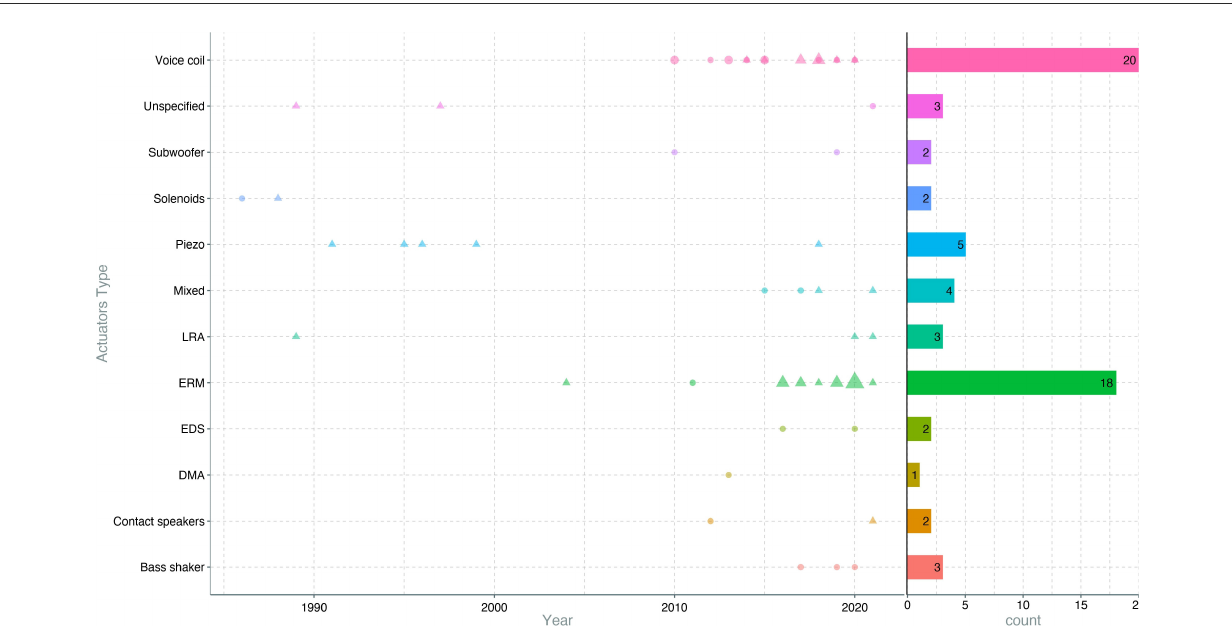
FIGURE4 Distribution of types of actuators used over time; a triangle indicate a wearable device, a circle indicates a fixed device and the size of the shape represents the amount of similar